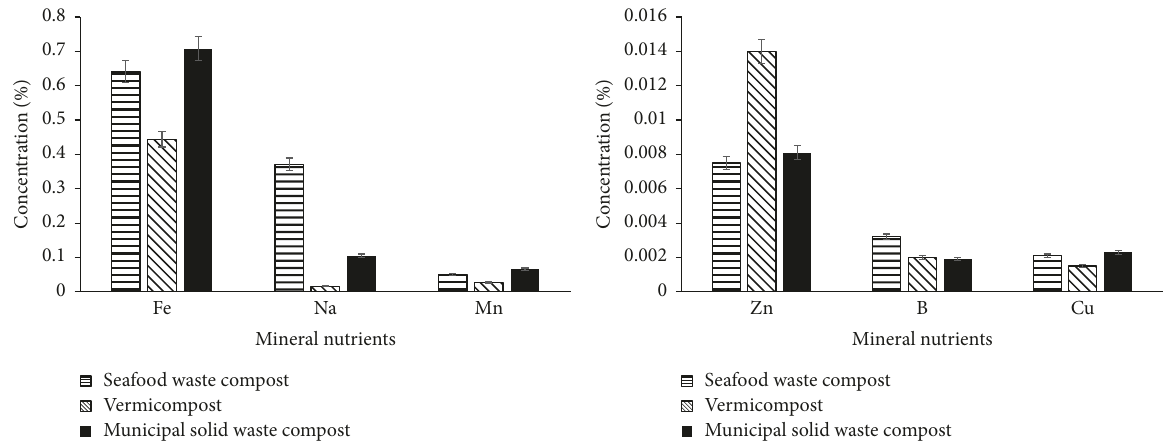
Figure 3: Micronutrients composition in seafood waste compost, vermicompost, and municipal solid waste compost. Iron (Fe); sodium (Na); manganese (Mn); zinc (Zn); boron (B); and copper (Cu).